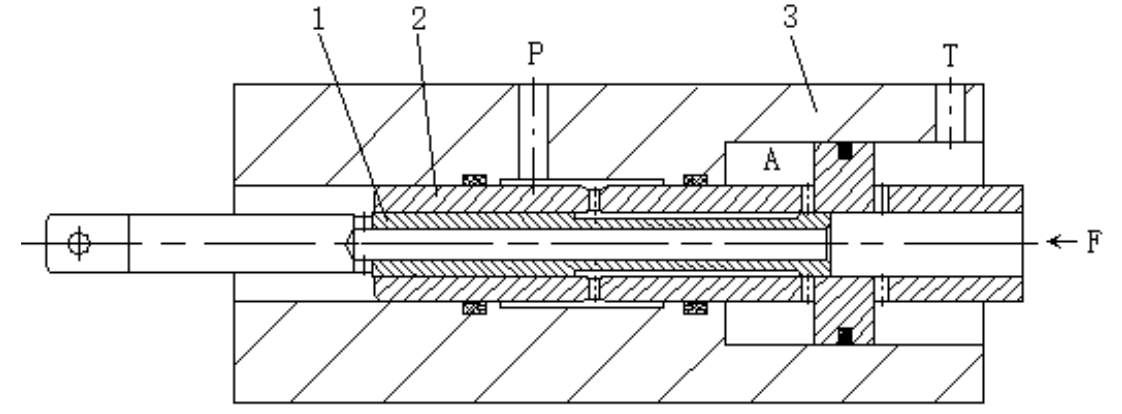
Figure 6. Schematic diagram of the main control valve.